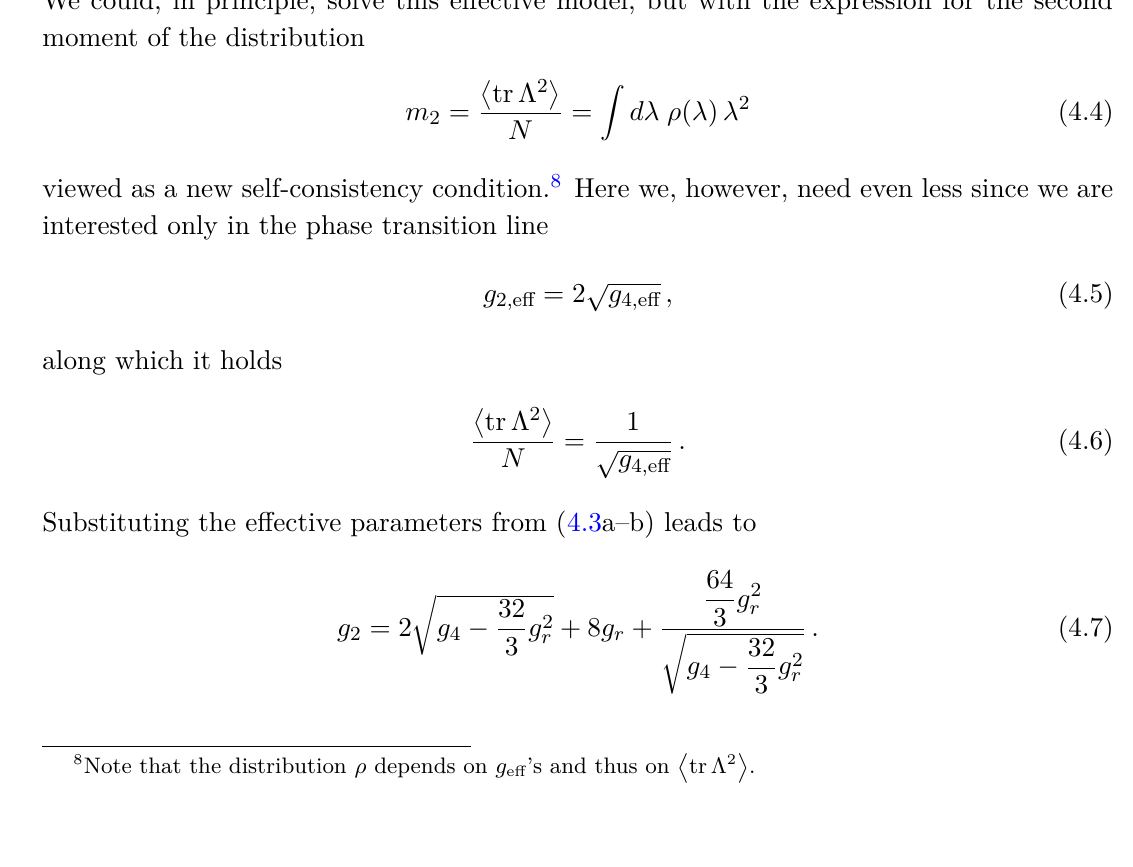
Figure 1 . Plots of the O ( g 3 (bottom to top), where the dashed, orange part is not to be trusted. The dotted, green line is the locus of transition lines’ minima ( g